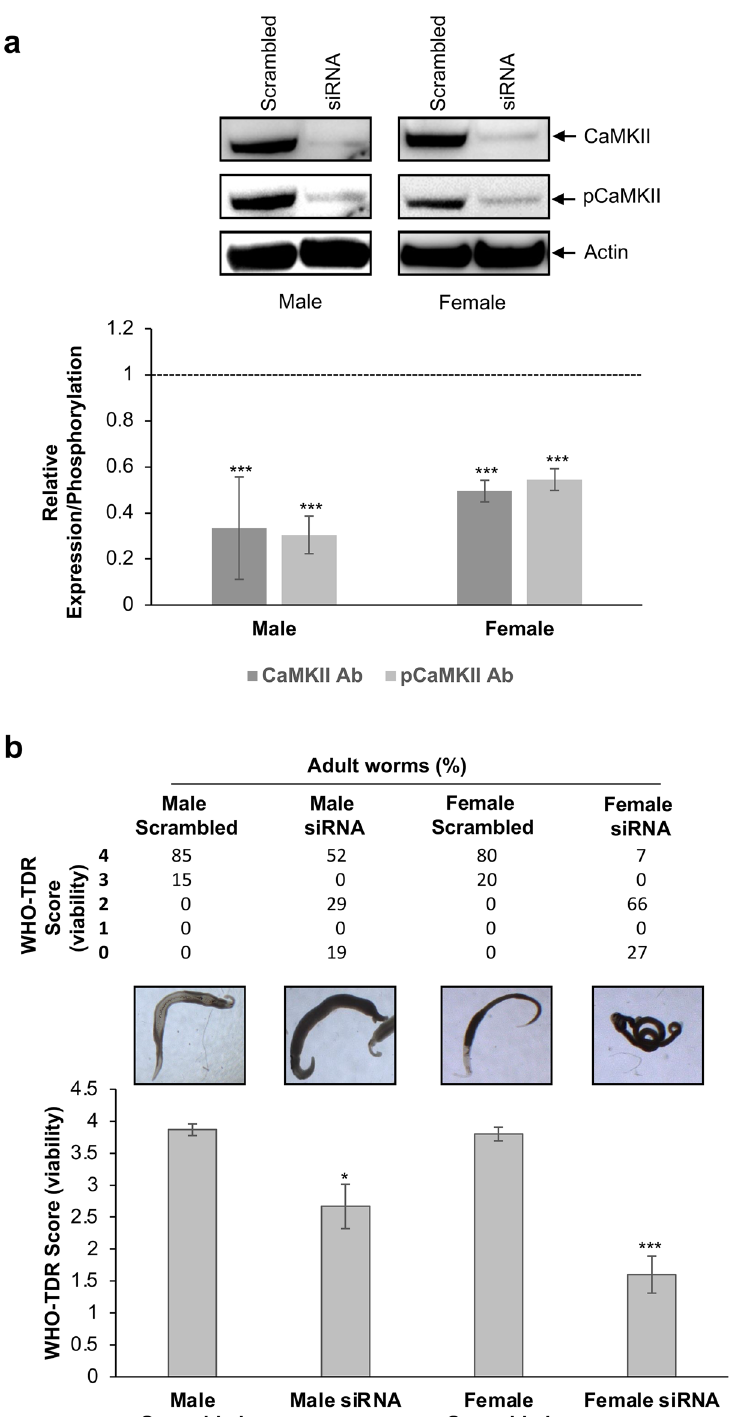
Figure 5. Suppression of CaMKII expression/activation in adult male and female Schistosoma mansoni , reduces worm movement and viability. ( a ) Adult worms were electroporated with either scrambled (control) small interfering ribonucleic acid (siRNA) or CaMKII siRNA and were cultured for four days before proteins were processed for western blotting with either anti-‘total’ CaMKII or anti-phospho CaMKII (Thr 286 ) antibodies; actin was used as an inter-lane loading control. Representative blots are shown. Mean relative changes (n = 3, ± SD; graph) in CaMKII expression/phosphorylation were determined and calculated relative to the levels present in the scrambled controls that were assigned a value of 1 (shown as dotted line). ( b ) Adult worms were also assessed for the effects of siRNA treatment on movement (viability) using the WHO- TDR score index, where 4 = normally active and 0 = total absence of motility; micrographs show representative worms for each treatment. The mean viability score (n ≥ 15 per treatment, ± SD; graph) of worms in each treatment was calculated. * p ≤ 0.05, and *** p ≤ 0.001 (ANOVA) when compared with the scrambled (control) siRNA for each worm